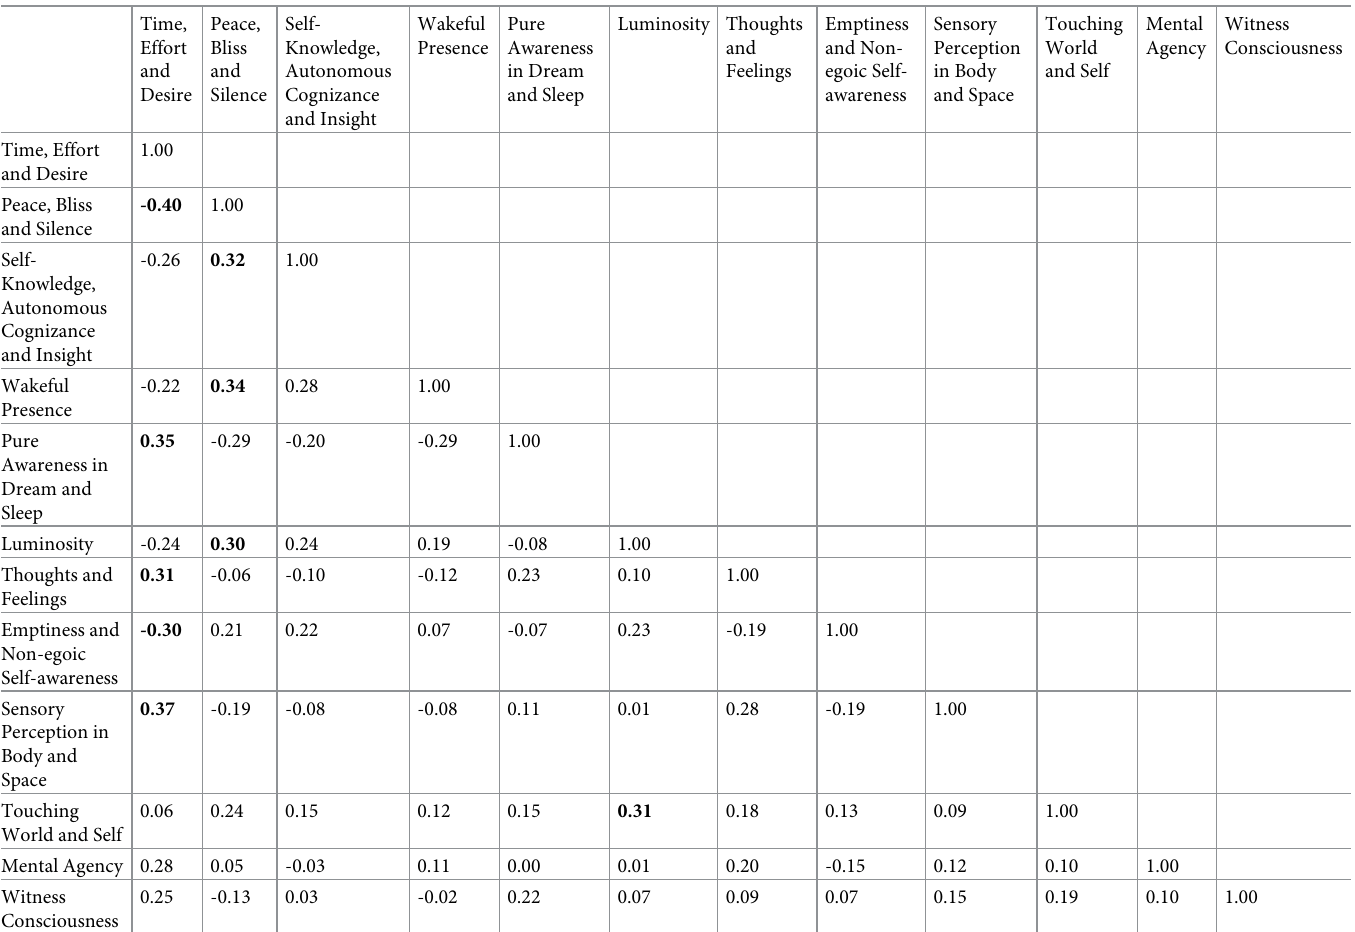
Table 7. Factor correlations a